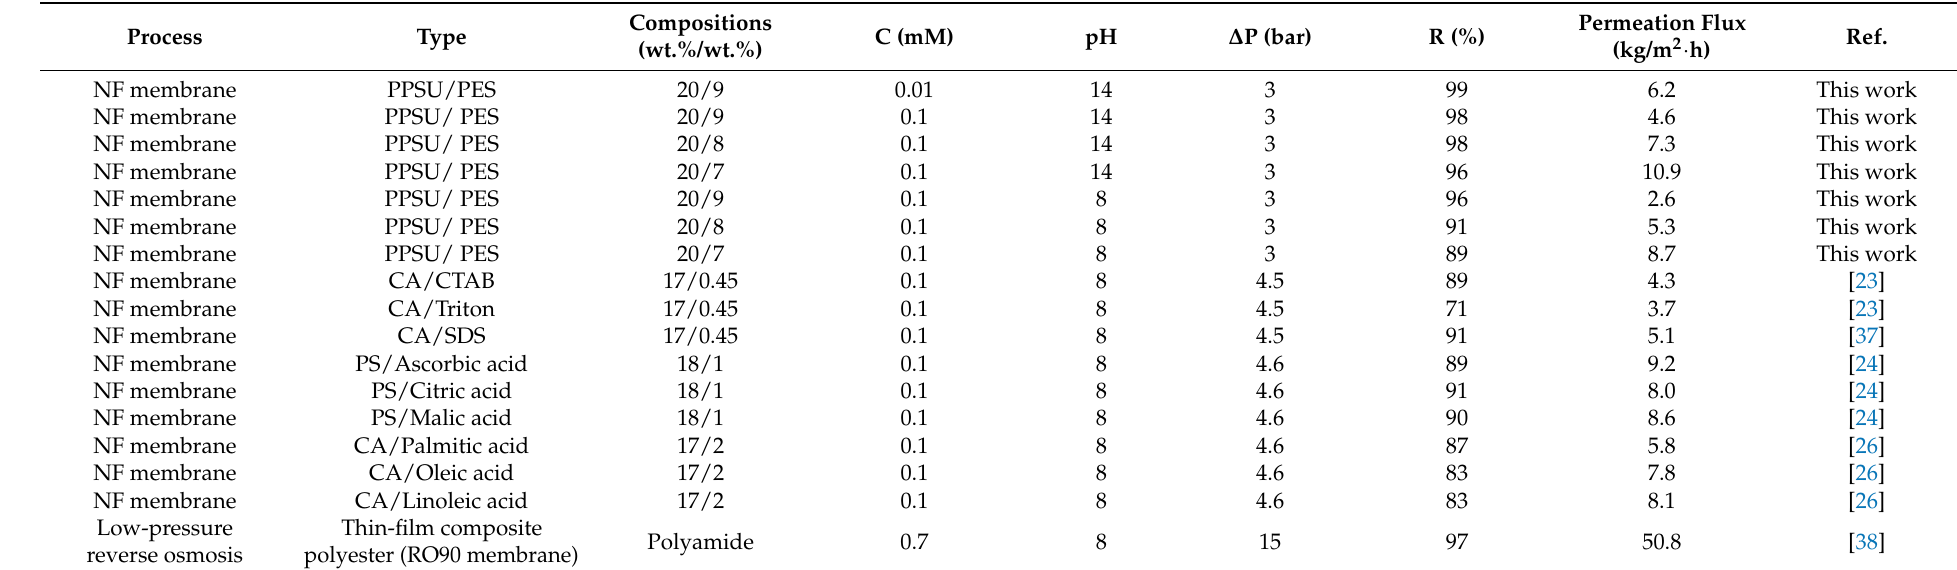
Table 3. Compare the results of 4-NP rejection of blend membranes against preceding